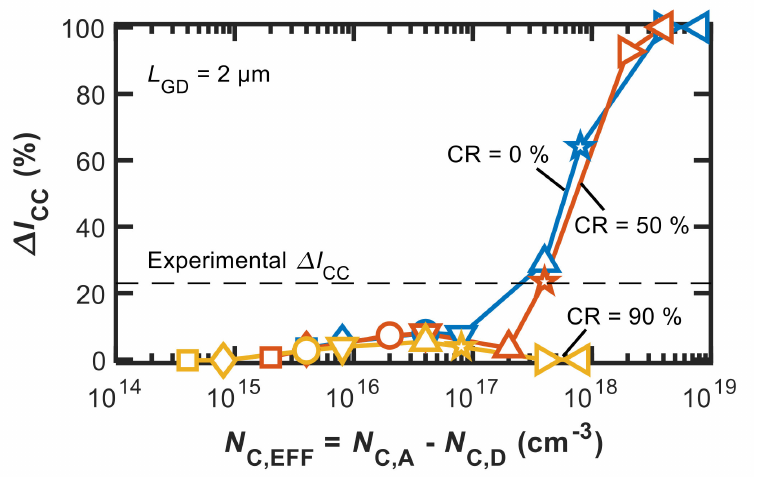
Figure 7. ∆ I D,CC vs. N C,EFF for CR = {0, 50, 90}%. The same symbols correspond to the same N C,A at different N C,D depending on